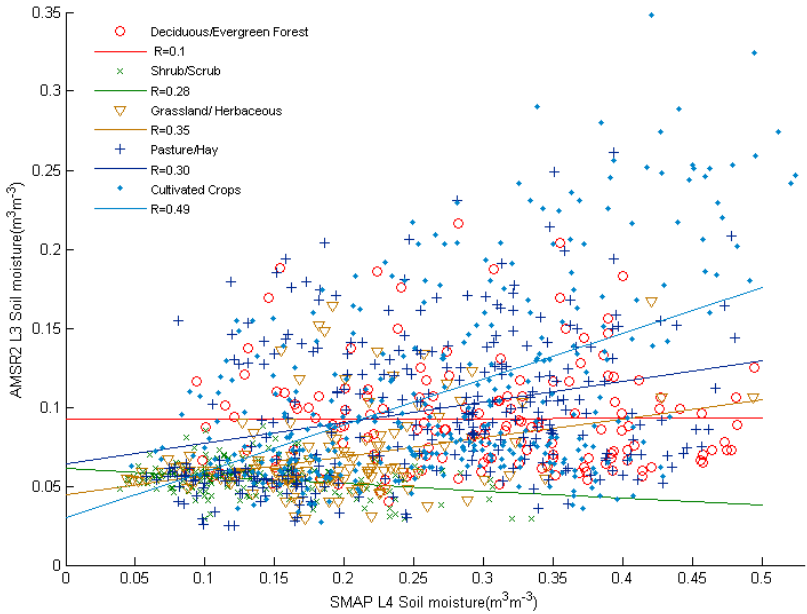
Figure 5. Comparison Soil moisture in different land covers between SMAP L4 and AMSR2 L3 data.